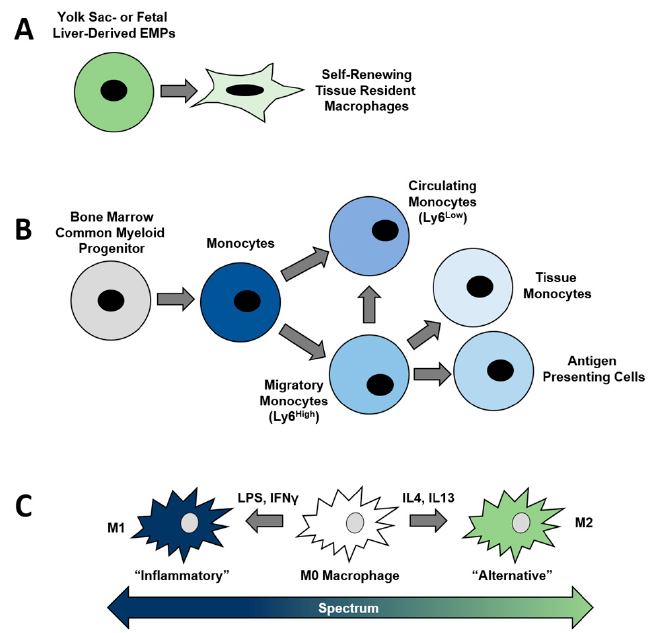
Figure 2. Origins and functional polarization of macrophages. ( A ) Tissue resident macrophages derive from the fetal yolk sac and liver. ( B ) Hematopoietic stem cell (HSC)-derived common myeloid progenitors give rise to myocytes and macrophages. ( C ) Inflammatory stimuli such as LPS and IFN- γ polarize macrophages towards and M1 phenotype, whereas IL-4 and IL1-3 promote M2